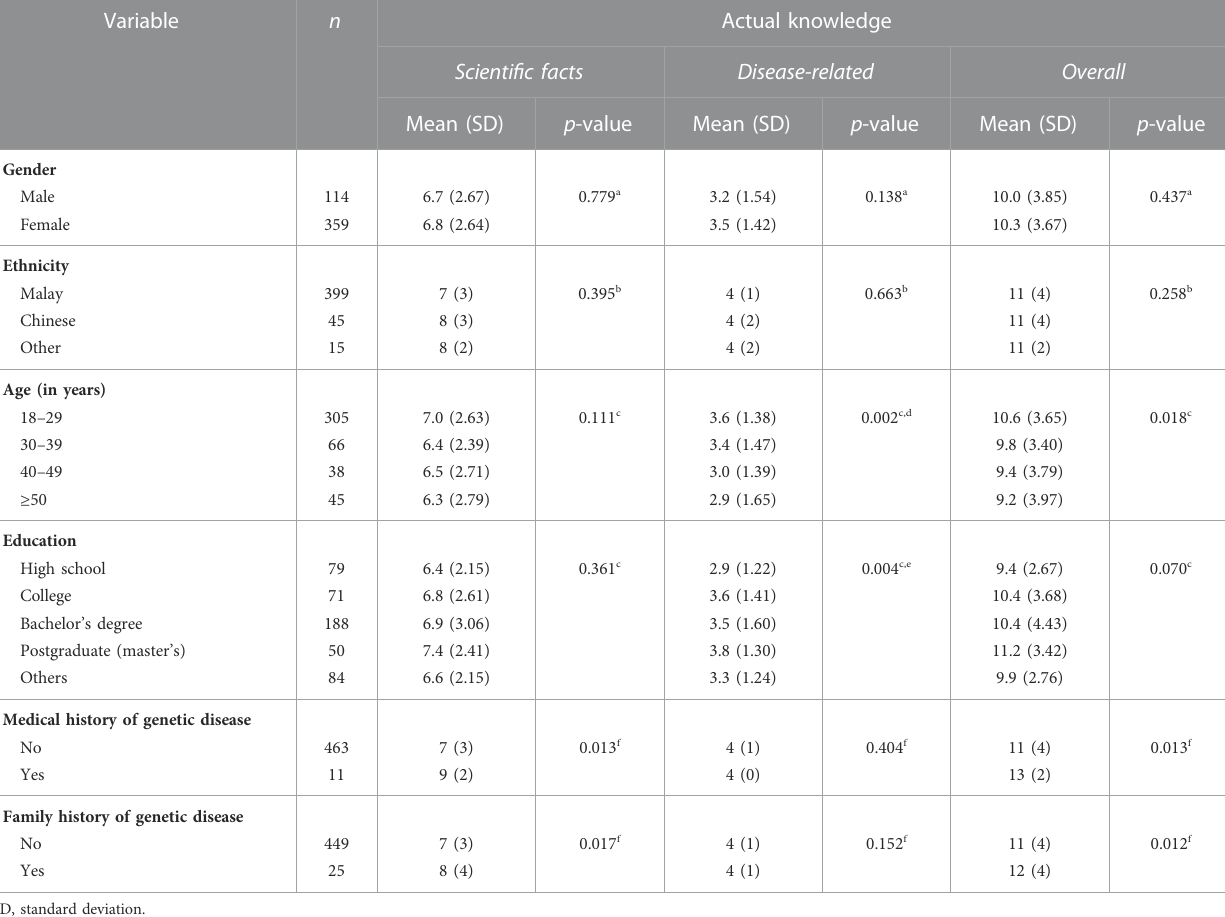
TABLE 3 Statistical analysis for the respective variables pertaining to actual knowledge of genetics.